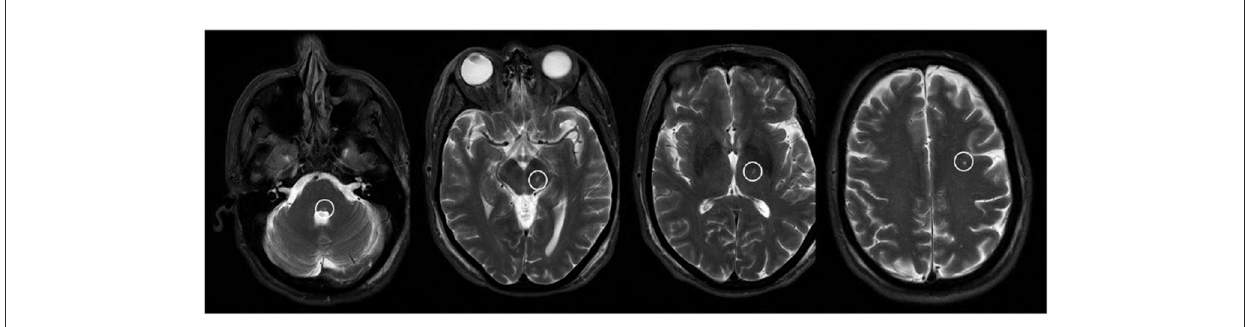
FIGURE1 T2-weighted MR images showing the cannula tract as a T2 hyperintensity extending from the dorsal pons through the midbrain, thalamus, and subcortical white matter.